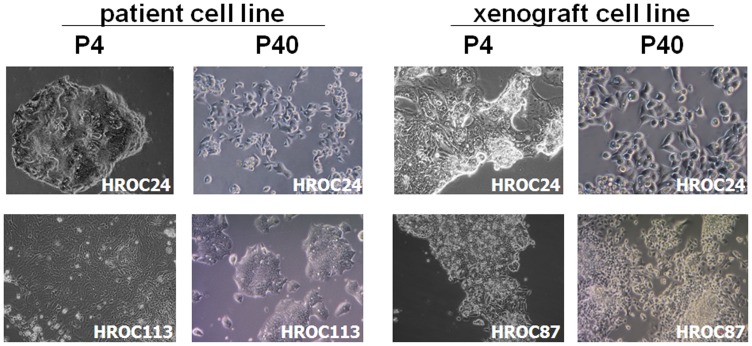
Light microscopy of MMR-D CRC cell lines both directly after establishment (P4) and following long-term in vitro culture (P40).(A) Morphology of patient-derived cell lines HROC24P and HROC113P. (B) Morphology of HROC24X and HROC87X. Both cell lines were established from xenopatients as described in material & methods. Original magnification x100.